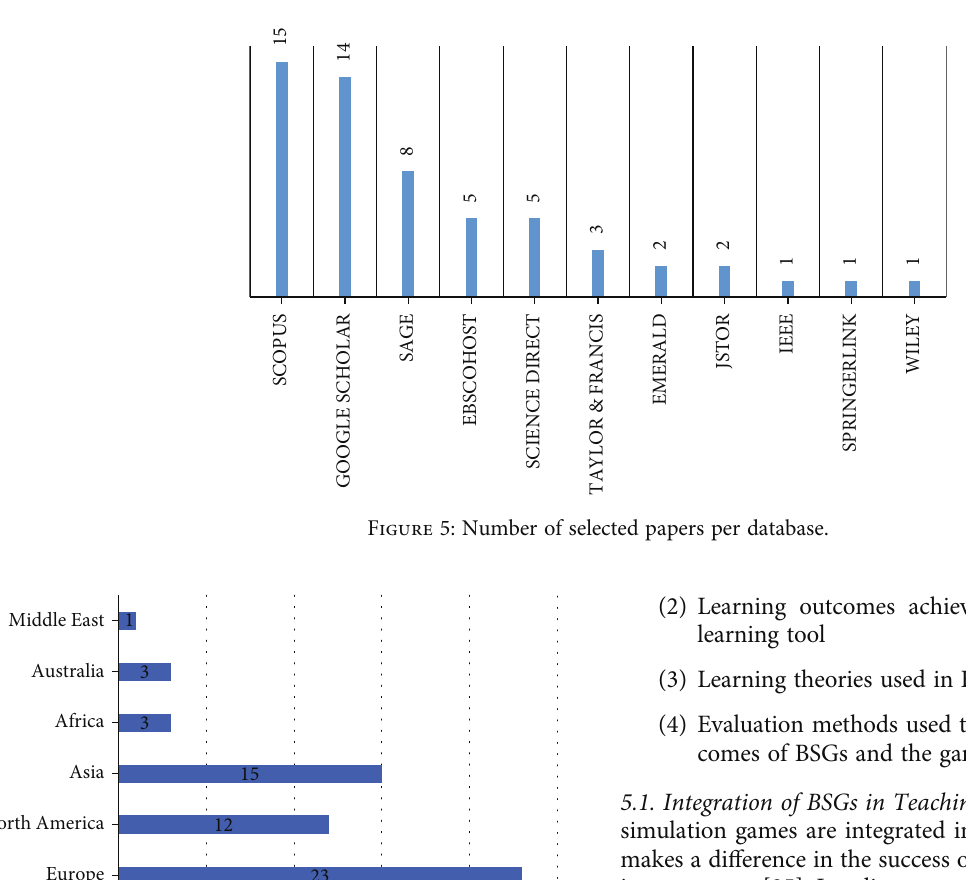
Figure 4: Number of selected papers per year.